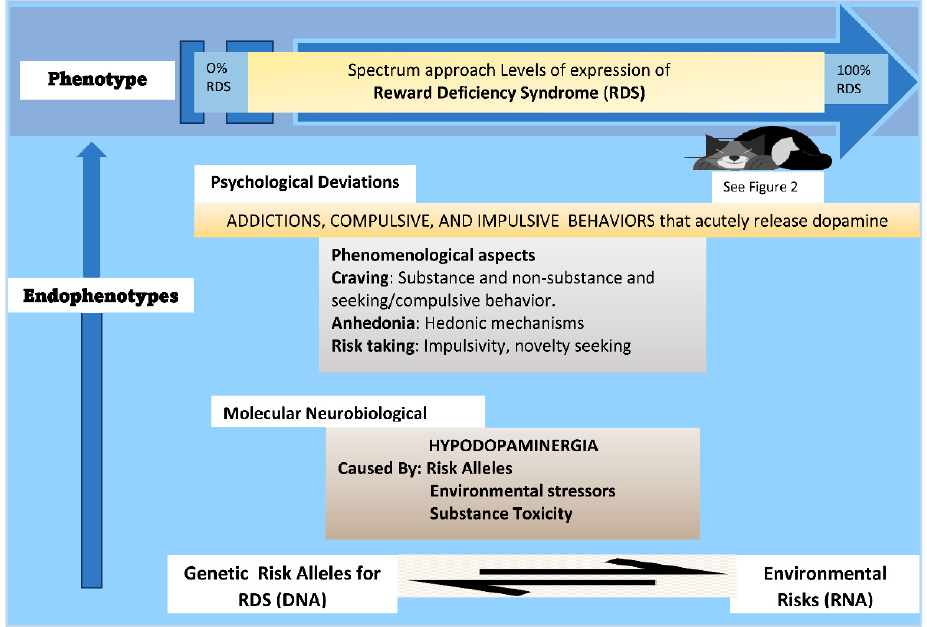
Figure 3. Summary of RDS Phenotype. This illustrates the relationship between endophenotypes and phenotype in RDS (modified from [126].